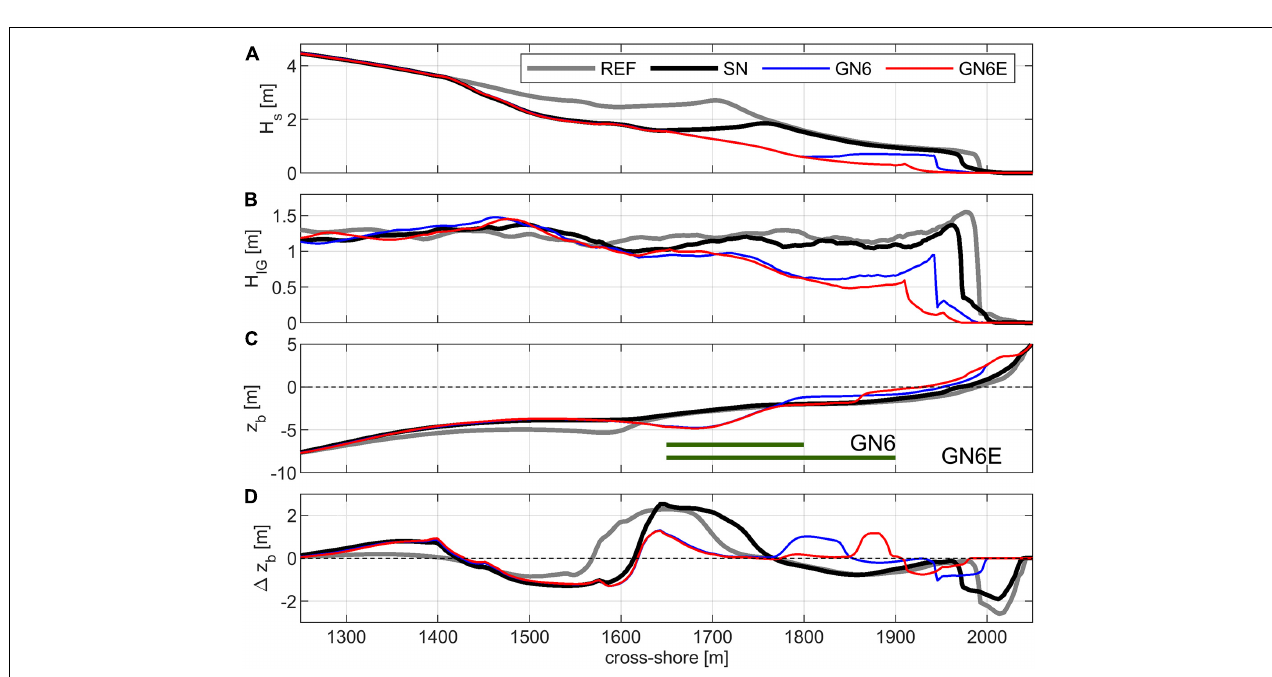
FIGURE 13 | Adaptation of green nourishment to a 1-week storm event ( H m = 5 m, T = 12 s), showing: (A) wave height simulated on pre-storm seabed profile; (B) infragravity (IG) wave height; (C) seabed after 1 week storm condition; (D) the change of seabed from initial profile (i.e., at the beginning of the 100 days simulation).